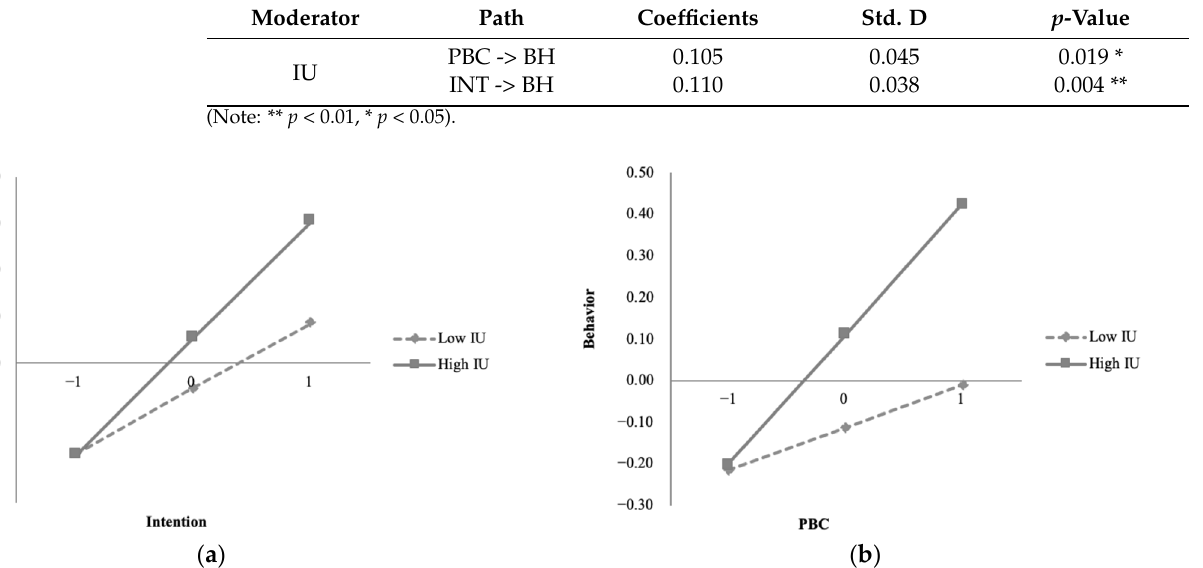
Table 5. Results of Structural Analysis.